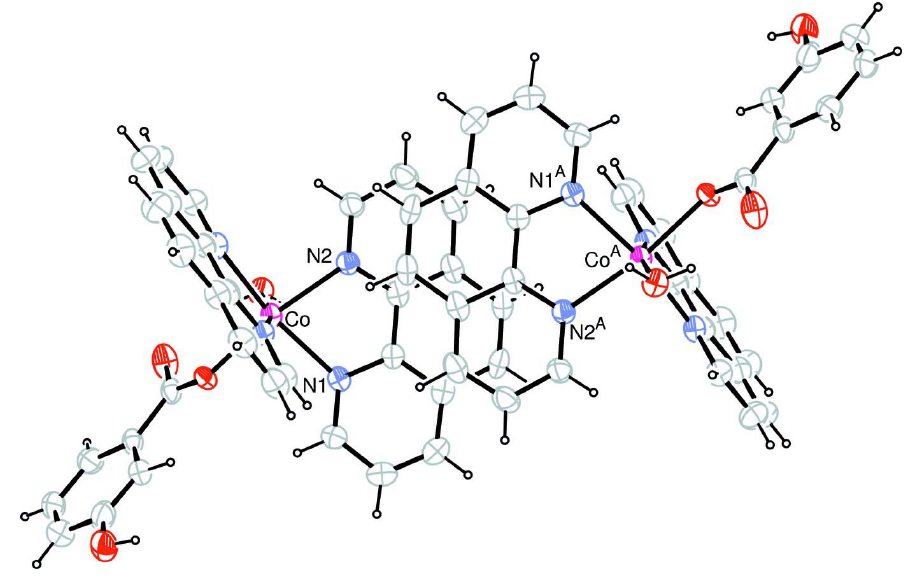
A diagram showing π - π stacking between N1-containing phen rings [symmetry code: (A) 1 - x ,- y ,- z